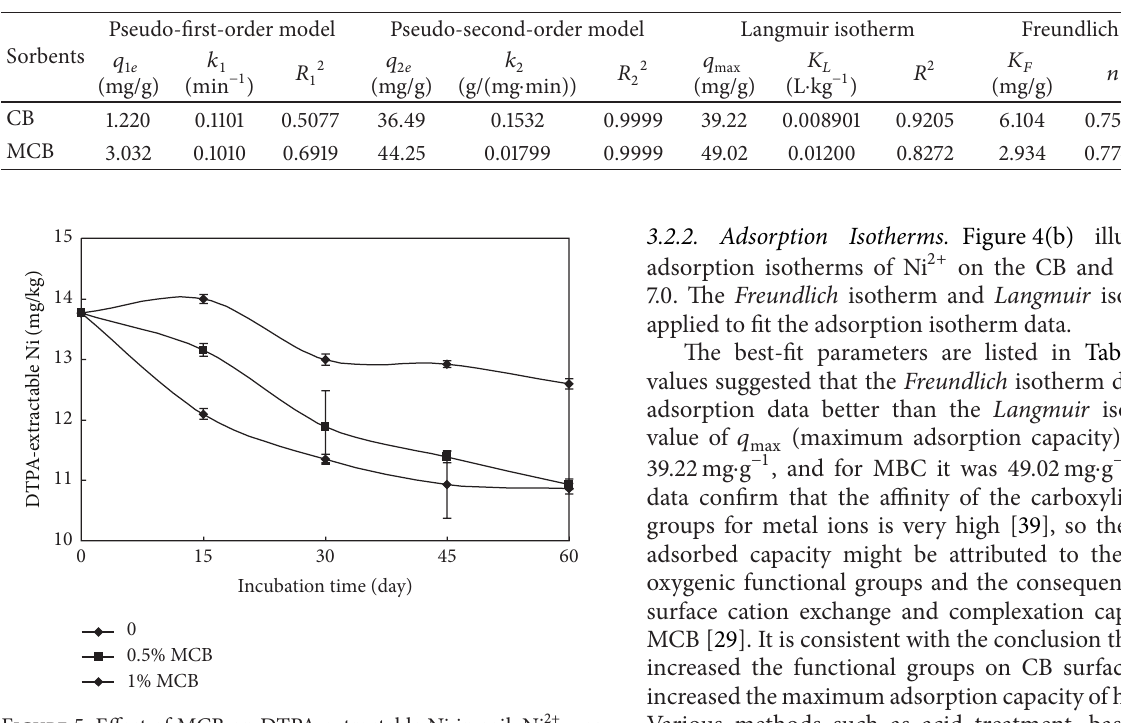
Table 1: The best-fit model parameters for adsorption of Ni 2+ on CB and MCB.